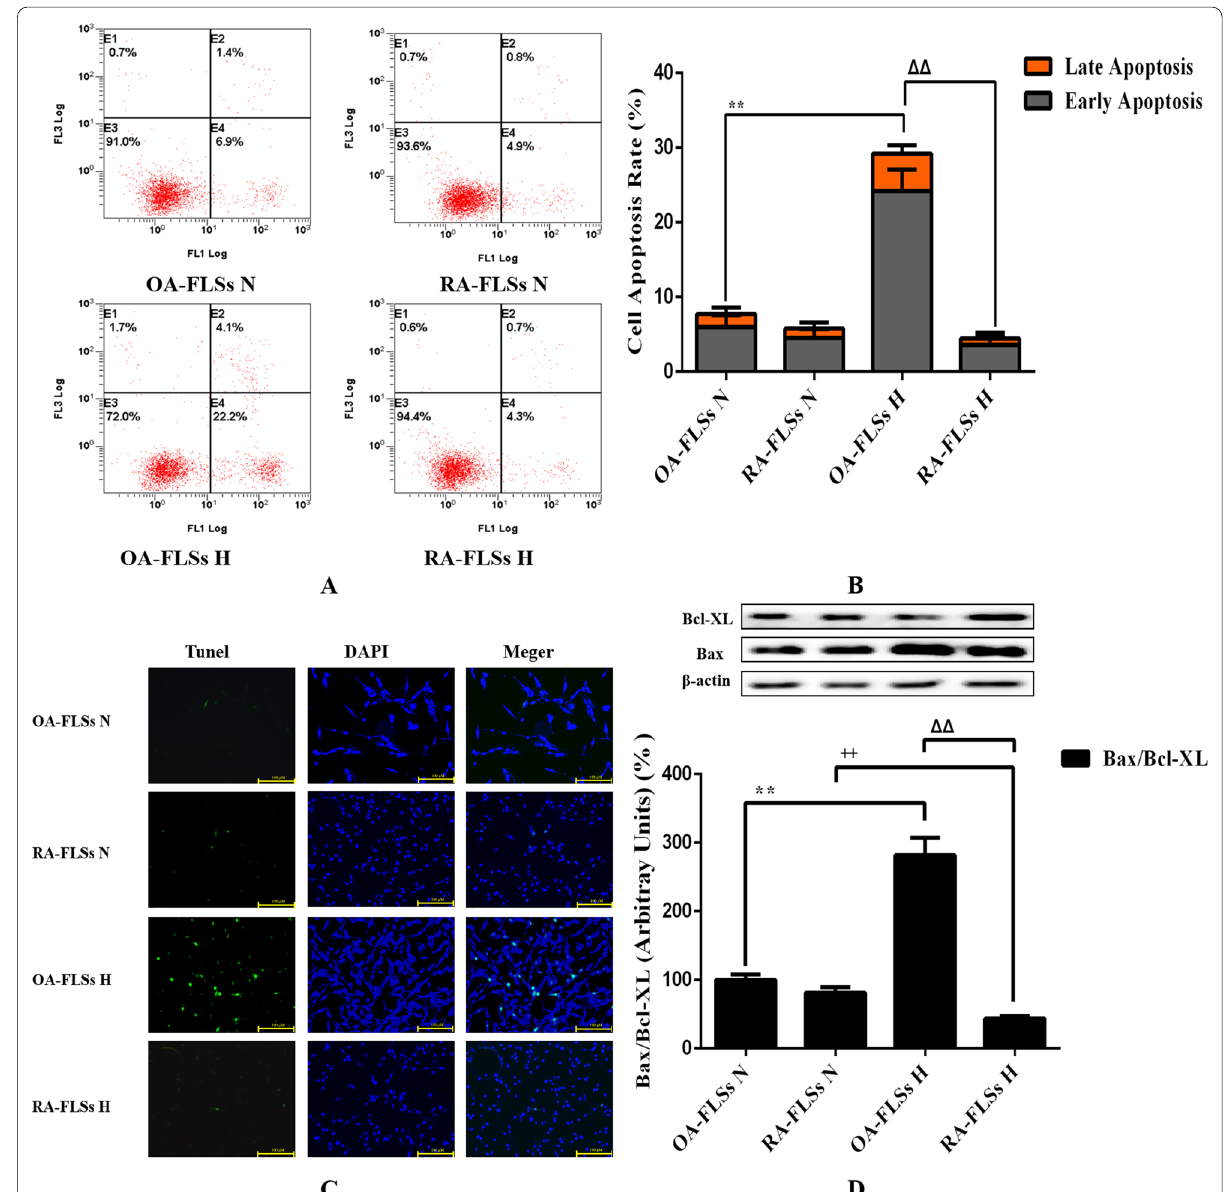
Fig. 2 Effects of hypoxia on the apoptosis of OA-FLSs or RA-FLSs. A After exposed to different oxygen concentrations for 24 h, cells were analyzed by flowcytometry using AV/PI double-staining; B Histogram depicts the quantitative data from the AV/PI double-staining (mean three independent experiments); C Representative fluorescence images of cells stained with TUNEL and PI to visualize apoptosis cells (Green) and nucleus (Blue), respectively; D The expression of Bax and Bcl-XL was analyzed by Western blot (mean experiments). # P < 0.05, ## P < 0.01 represents the comparison between OA-FLSs N and RA-FLSs N; *P < 0.05, **P < 0.01 represents the comparison between OA-FLSs N and OA-FLSs H, + P < 0.05, ++ P < 0.01 represents the comparison between RA-FLSs N and RA-FLSs H, Δ P < 0.05, ΔΔ P < 0.01 represents the comparison between OA-FLSs H and RA-FLSs